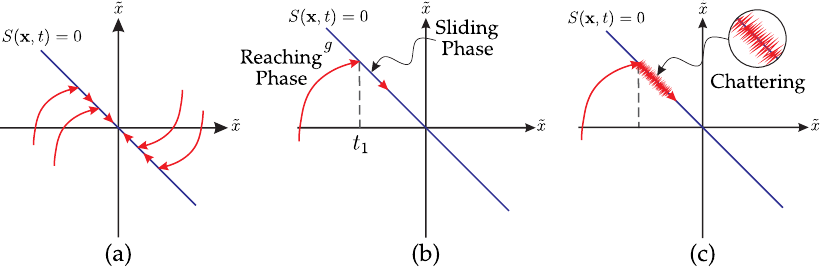
Figure 2. Graphic interpretation of the SMC. ( a ) State trajectories. ( b ) Evolution of the state trajectory. ( c )